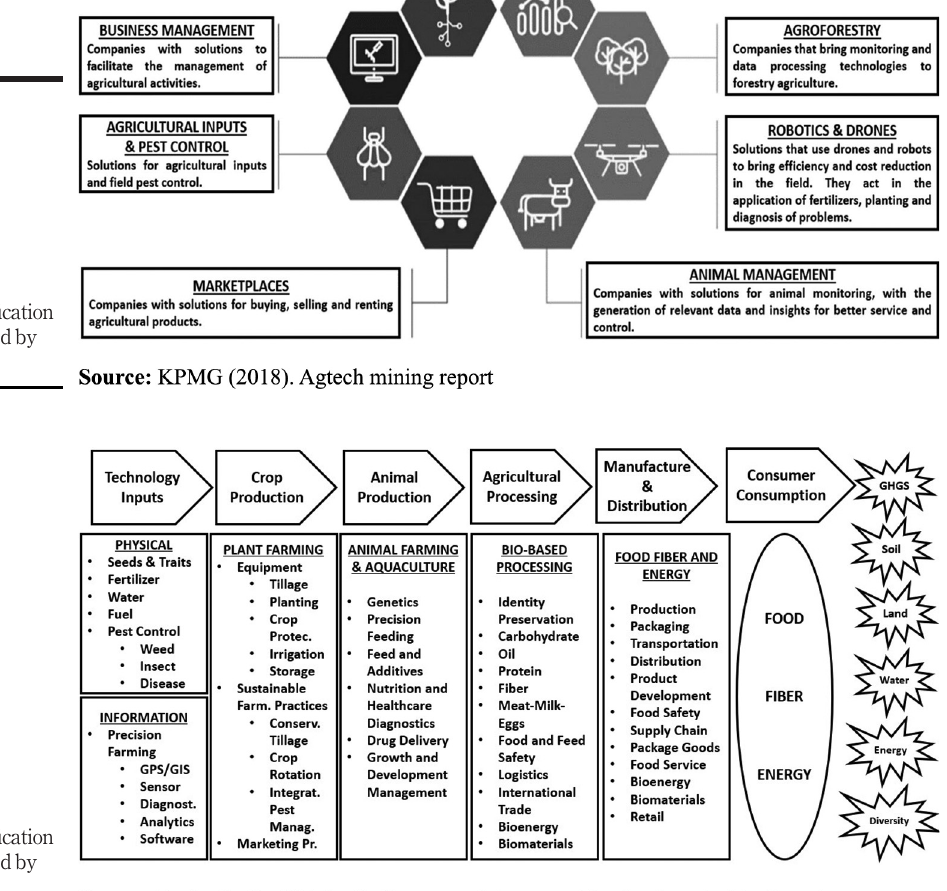
Figure 5. Agtech classi fi cation model proposed by Dutia